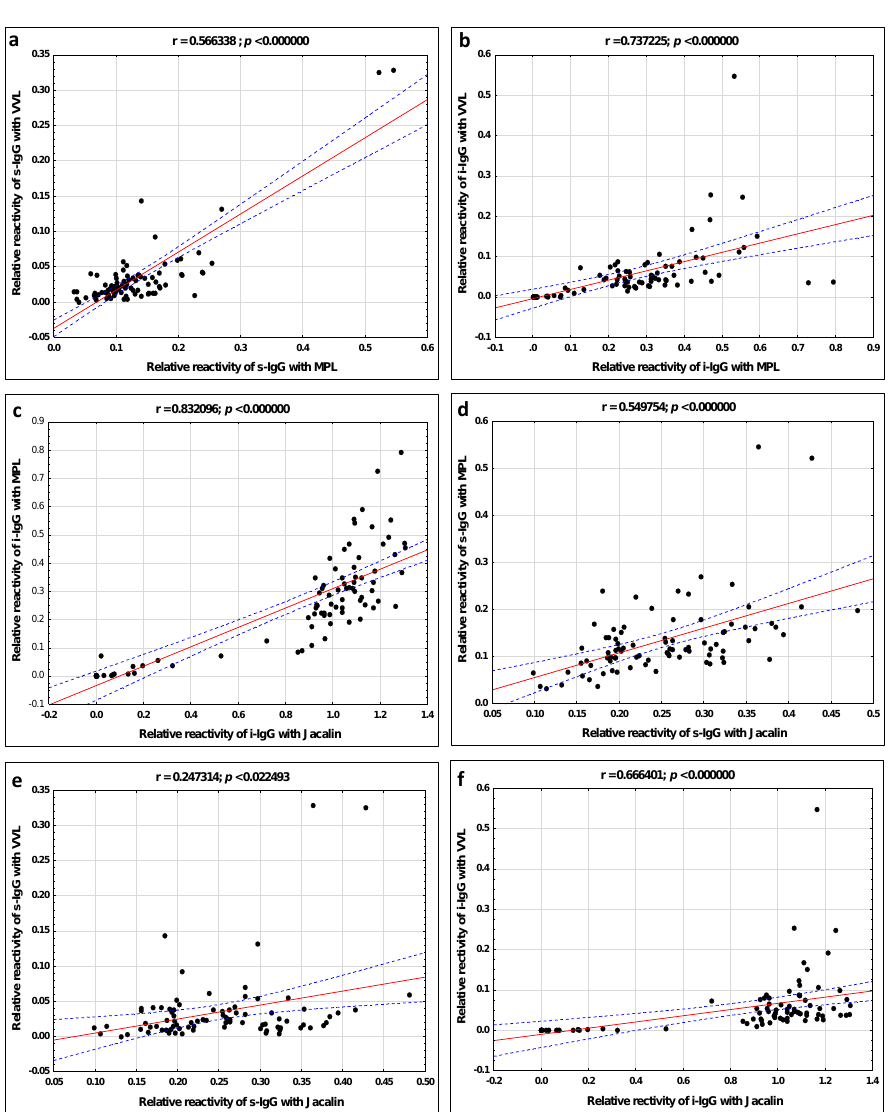
Figure 2. Correlations between relative reactivities of s-IgG and i-IgG O-glycans with specific lectins ( a – f ). Correlations were estimated according to a Spearman test, and a two-tailed p -value of less than 0.05 was considered significant. The 95% confidence interval is marked by dotted blue lines. MPL — Maclura pomifera lectin, VVL — Vicia villosa lectin and Jacalin — Artocarpus integrifolia lectin. For specificity of lectins see Materials and Methods section.